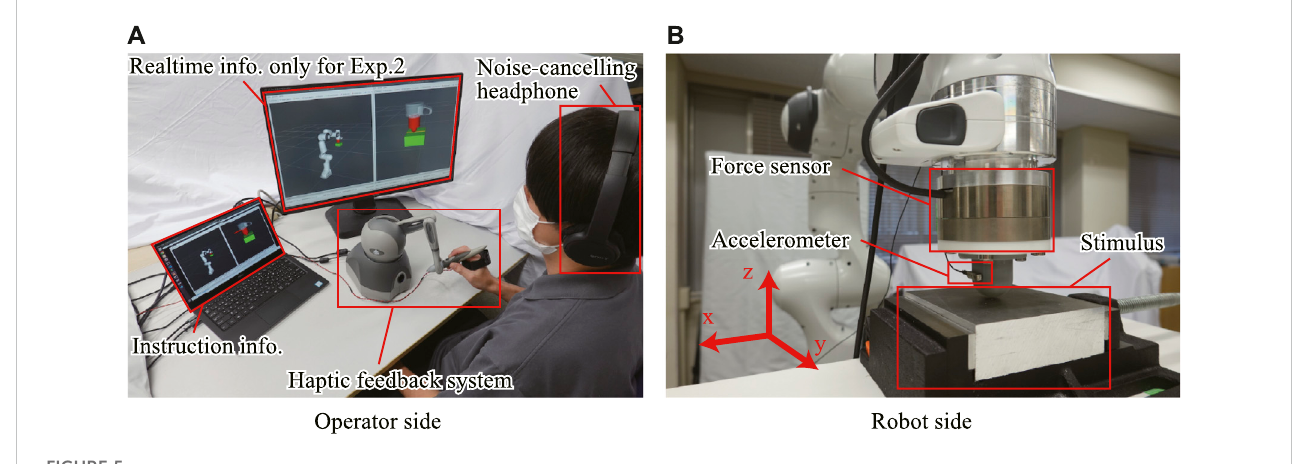
Experimental environment. (A) operator side and (B) robot side. The operator controls based on the visual information on the screens and discriminates the stimuli based on the haptic feedback information and the right screen for real-time robot condition feedback is used only in Experiment